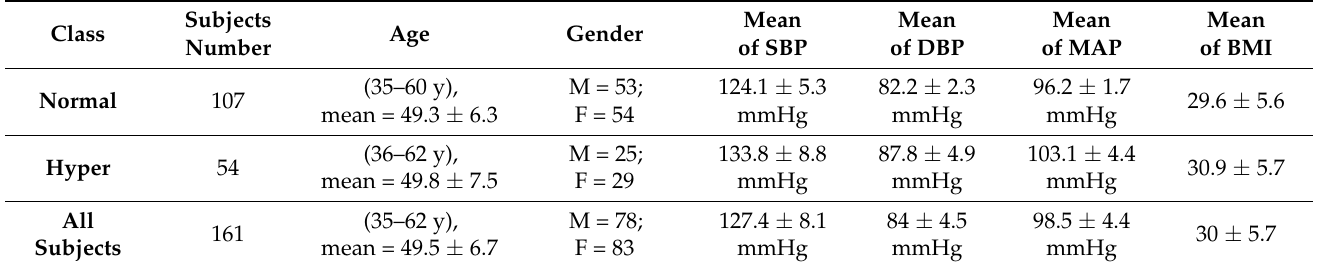
Table 3. MAP BP-based dataset demographics